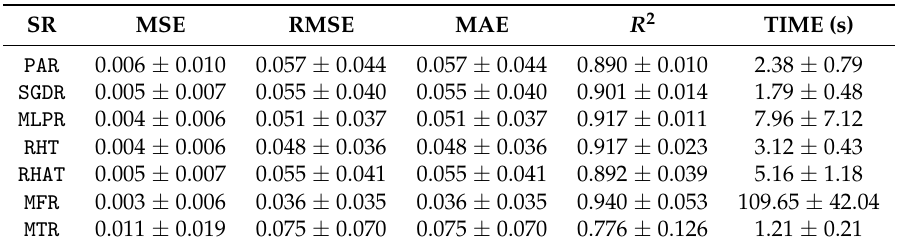
Table 6. Results of the experiment 4: no variable selection with a 20% of preparatory instances. Note that RMSE = MAE because all differences are equal.